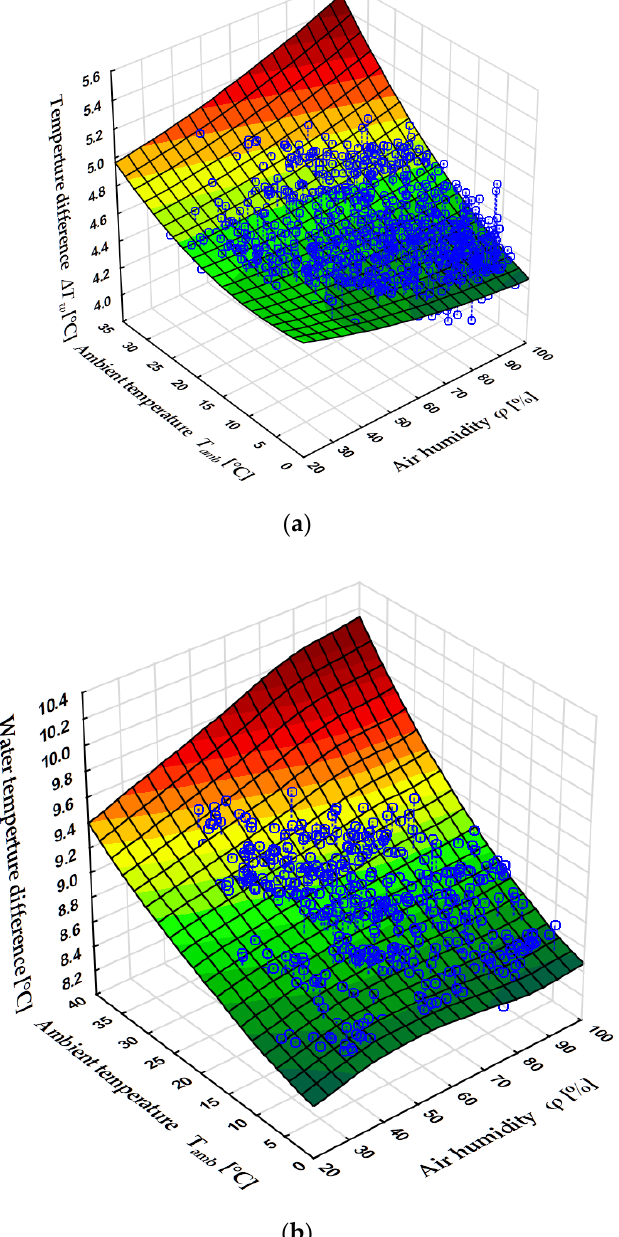
Figure 4. The water cooling level ΔT w as a function of ambient temperature T amb and air humidity φ for power range ( a ) 390 − 410 MWe and for power range ( b ) 890 − 910 MWe of power unit 5. Source: own elaboration (Statistica software).